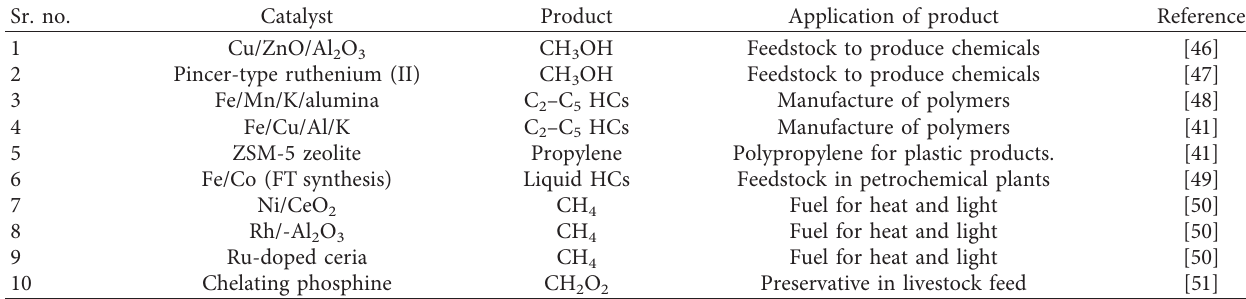
2 into the respective products and their applications.